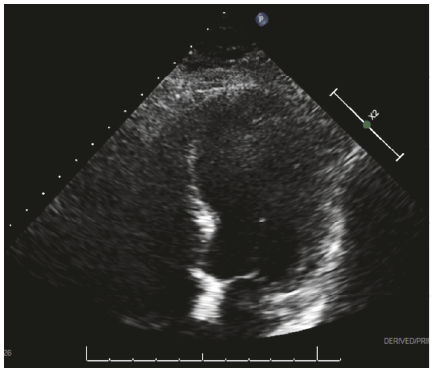
Figure 1: Apical four-chamber view demonstrating mid to apical ballooning of left